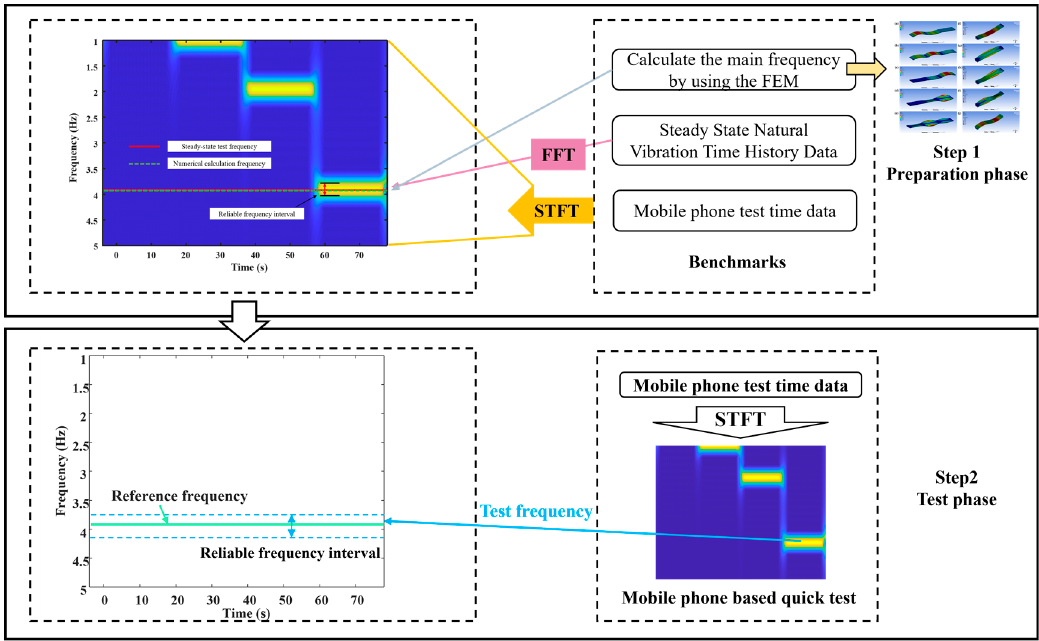
Figure 4. Vibration signal acquisition